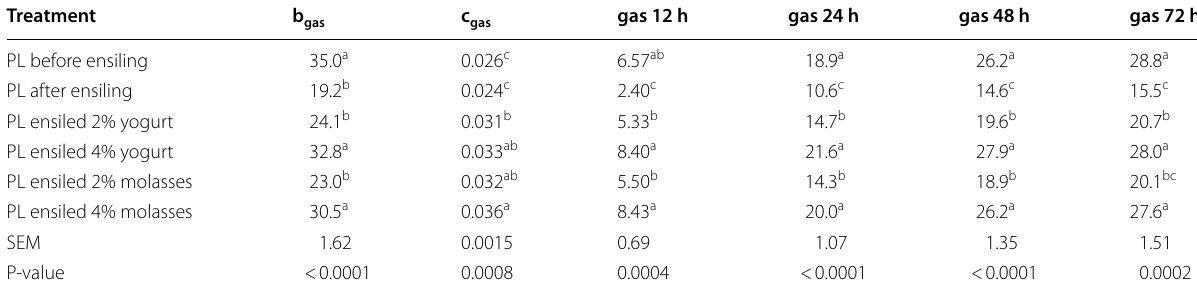
Means within columns followed by the same letter are not different PL pomegranate leaves, b gas (ml/200 mg DM) potential gas production, c gas (%/h) fractional rate of gas production; gas 12, 24, 48, and 72 h (ml/200 mg DM): cumulative gas production after 12, 24, 48, and 72 h incubation SEM standard error of the mean